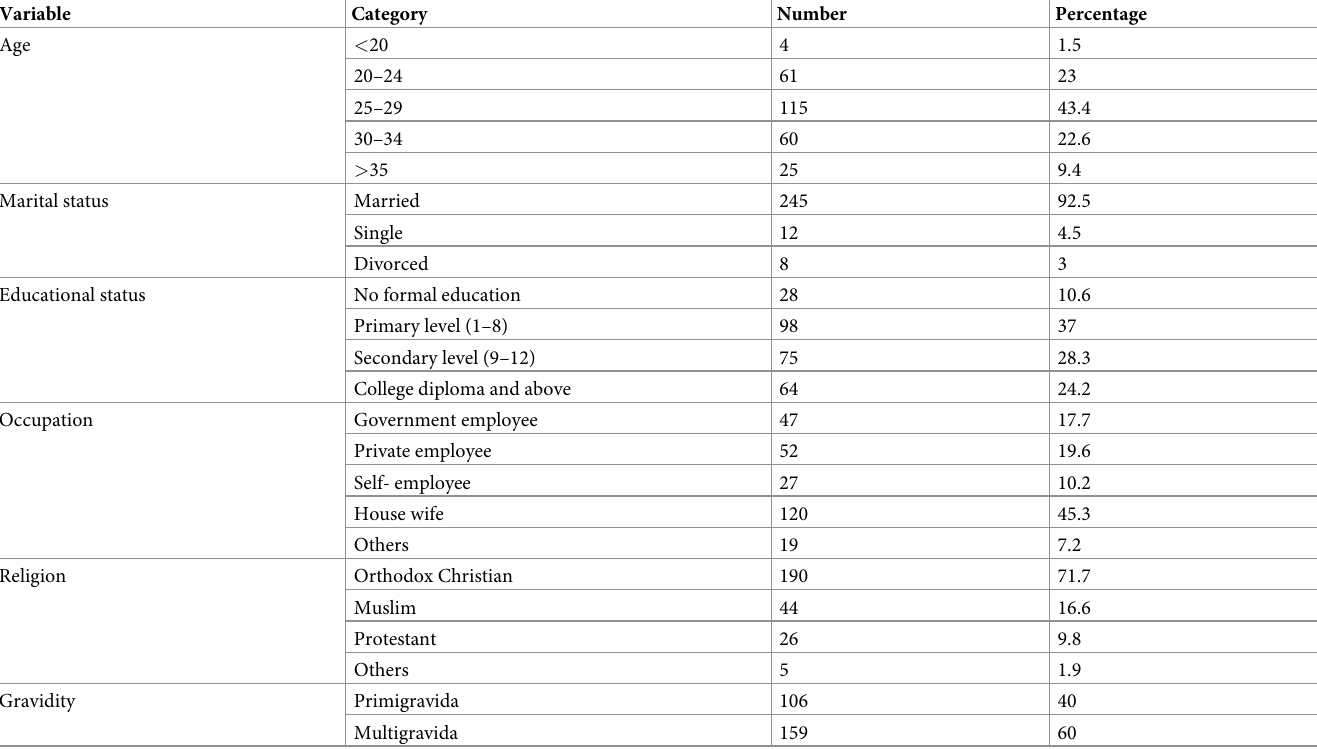
Table 1. Socio-demographic characteristics of HBsAg positive delivering mothers in governmental hospitals in Addis Ababa,